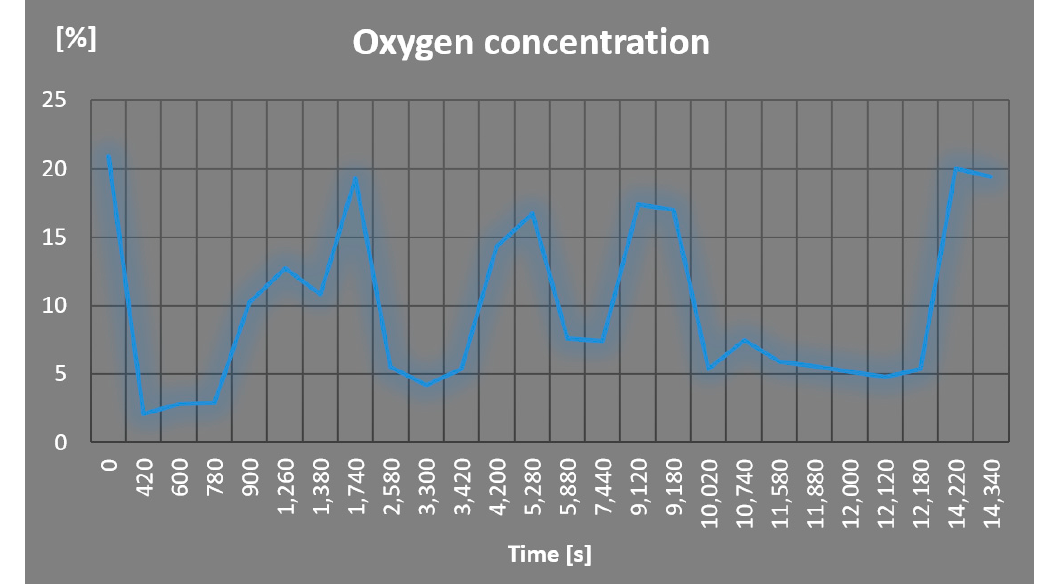
Figure 8. Evolution of the oxygen concentration in the exhaust gases. Energies 2019 , 12 , x FOR PEER REVIEW